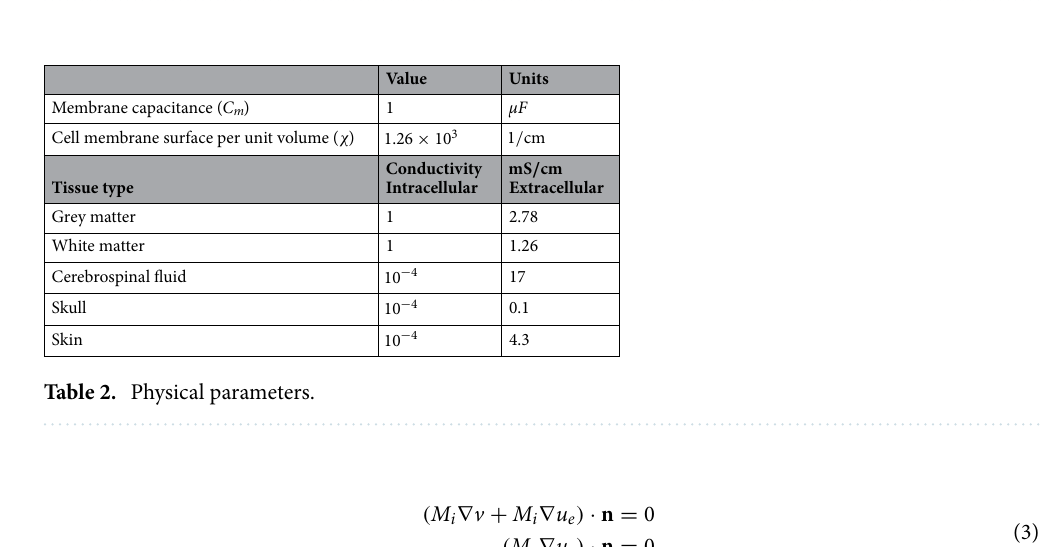
Table 1. A short summary of the models considered in this study. Models A and B are systems of ordinary differential equations (ODEs) describing cell membrane dynamics, and are coupled with the Bidomain model, a partial differential equations (PDE) in the two-dimensional models, C and D, as well as the three- dimensional models, E, F, and G.